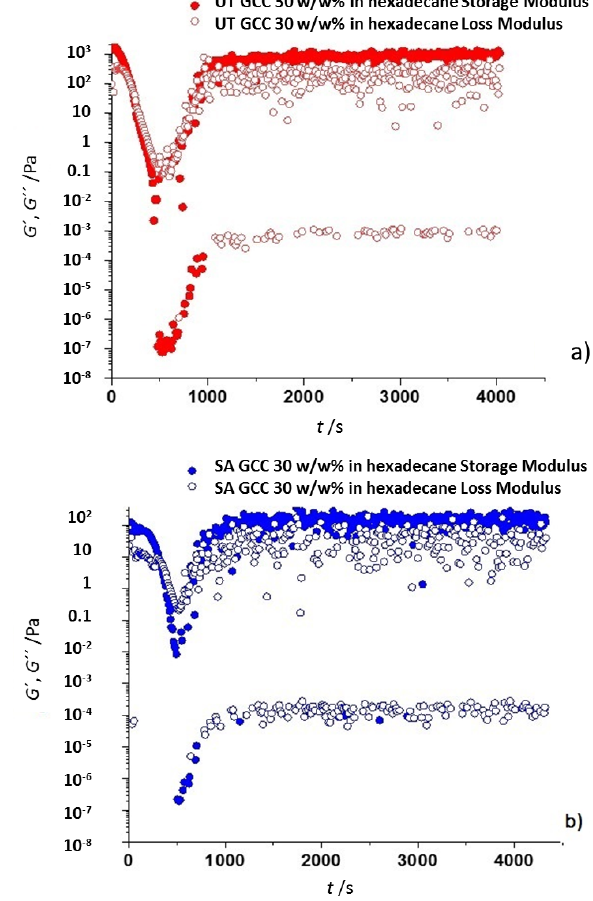
Figure 6: Viscoelastic stress moduli reduction and recovery under oscillation as strain is ramped up and then down – finally measure- ments continue under conditions of constant low-level strain: (a) untreated UT GCC at 30 w/w% solids in hexadecane, (b) fatty acid treated SA GCC at 30 w/w% solids in